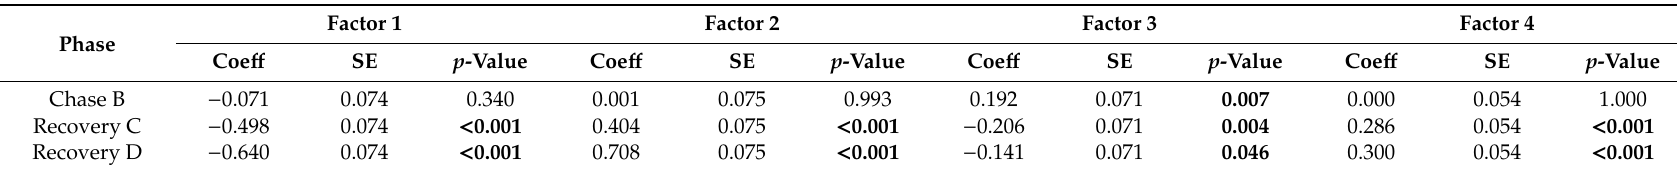
Table 3. Comparison between Factor Analysis for Fixed Term Descriptors applied by a panel of 16 students on 80 images of calves ( n = 20) during the calf pursuit (chase) and calf recovery after roping (recovery) phases of a calf roping event. Significant values appear in